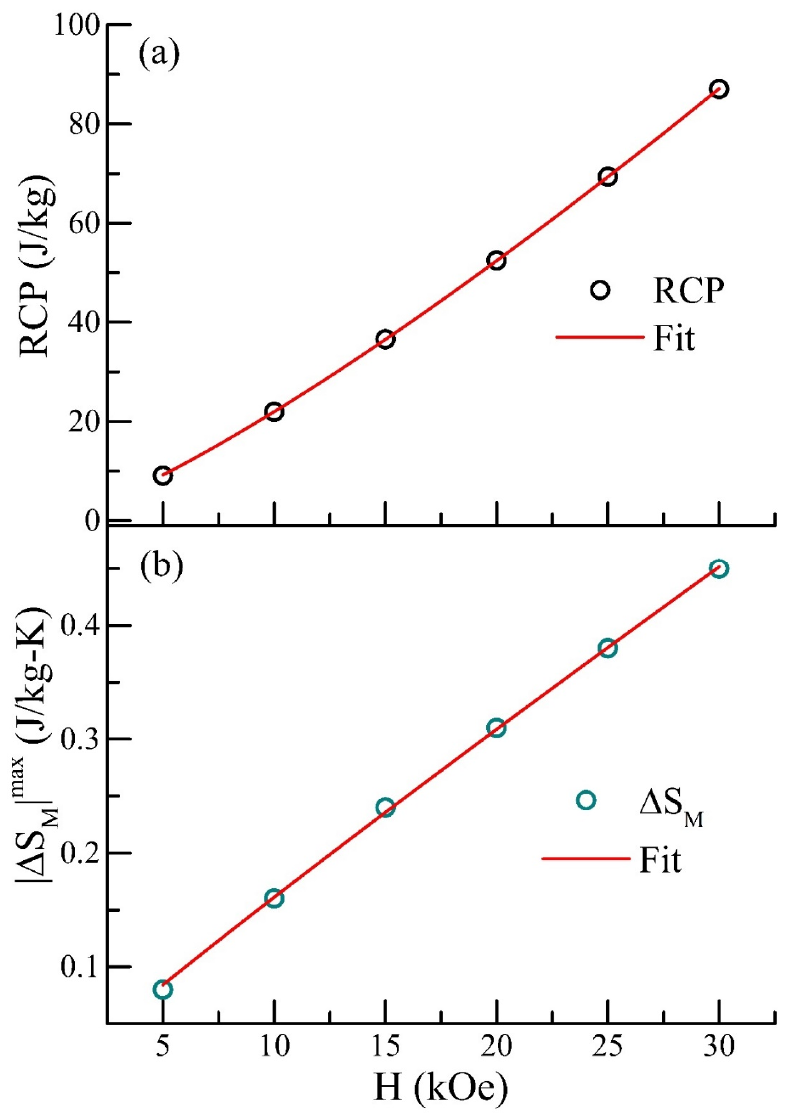
Figure 5. Magnetocaloric parameters as functions of applied magnetic field change: ( a ) RCP vs. H plot; ( b ) ∆ S M Peak vs. H plot. Power law fitting (~H n ) is displayed by solid line.